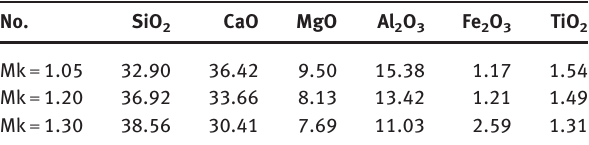
Table 1: Chemical composition of fiber/%.